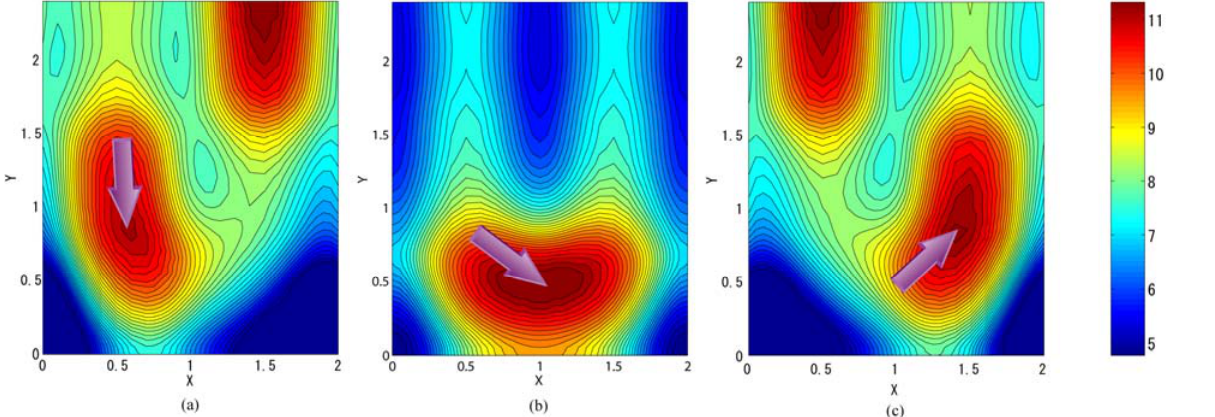
Figure 11. Channel potential profile at a fold of a four-phase transfer ISAS. Each memory element has a size of . Arrows indicate the proposed reverse transfer direction along the